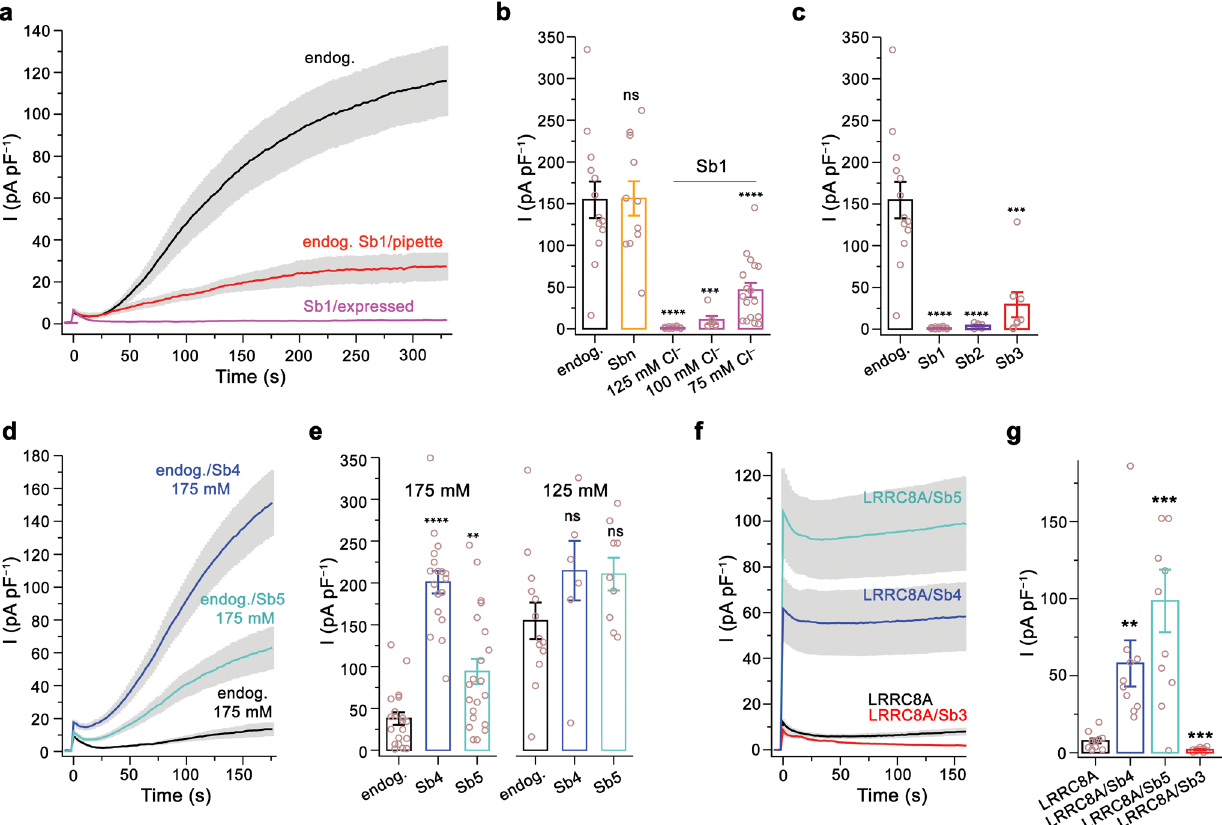
Fig. 2 Functional characterization of sybodies targeting the LRR domains. a Average current density of HEK293 cells in response to a decrease of the intracellular ionic strength. Currents from WT cells (endog.) with a pipette solution containing 125 mM salt (black, n = 11), additional 1 µ M of Sb1 (red, n = 10) or from cells expressing Sb1 (magenta, n = 12). b Currents of cells expressing Sb1 at indicated intracellular ion concentrations (125 mM Cl 100 mM Cl i − , n = 6; 75 mM Cl i − , n = 18). Non-transfected cells (endog., n = 13) and cells expressing Sbn ( n = 11), both recorded at 125 mM Cl i − , are shown for comparison. c Currents (at 125 mM Cl i − ) from cells expressing different inhibitory sybodies (endog, n = 13; Sb1, n = 12; Sb2, n = 8; Sb3, n = 8). d Average response (at 175 mM Cl i − ) of HEK293 cells expressing the potentiating sybodies Sb4 (blue, n = 17) and Sb5 (cyan, n = 21) compared to WT (black, n = 20). e Current-densities of cells expressing Sb4 and Sb5 in comparison to WT cells at 175 mM (endog., n = 20; Sb4, n = 17; Sb5, n = 21) and 125 mM Cl i − (endog., n = 13; Sb4, n = 7; Sb5, n = 9). f Average response of LRRC8 − / − cells expressing mouse LRRC8A (black, n = 11) or LRRC8A and the respective sybodies Sb4 (blue, n = 10), Sb5 (cyan, n = 11) and Sb3 (red, n = 11) at 75 mM Cl i − . g Mean current-densities of LRRC8 − / − cells expressing mouse LRRC8A (black) and the indicated sybodies (LRRC8A, n = 11; Sb4, n = 10; Sb5, n = 11; Sb3, n = 11). Currents are recorded at 100 mV ( a , d , f , g ) or 80 mV ( b , c , e ) by patch-clamp electrophysiology in the whole-cell con fi guration. b , c , e , g Values of individual measurements are displayed as circles, mean current levels as bars. Asterisks indicate signi fi cant deviations from WT (endog.) in a two-sided one sample t -test, ns refers to non-signi fi cant differences. ( b Sbn p = 0.96, Sb1 125 mM p < 0.0001, Sb1 100 mM p = 0.0004, Sb1 75 mM p < 0.0001, c Sb2 p < 0.0001, Sb3 p = 0.0006, d Sb4 175 mM p < 0.0001, Sb5 175 mM p = 0.0023, Sb4 125 mM p = 0.147, Sb5 125 mM p = 0.087, g Sb4 p = 0.038, Sb5 p = 0.0006, Sb3 p = 0.0009). a – g Data are from independent biological replicates, errors are